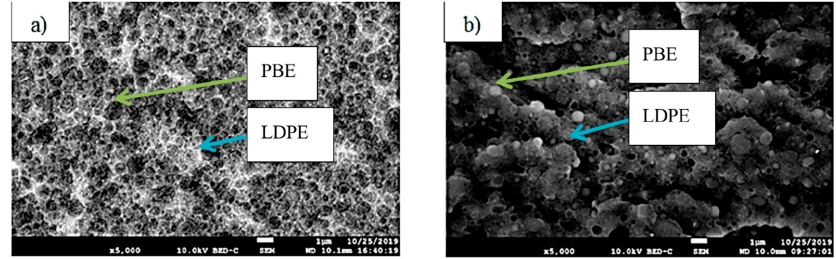
Figure 5. SEM images of the cross sections of 60%LDPE / 40%PBE ( a ) and 40%LDPE / 60%PBE ( b ). LDPE is whiter and in the PBE is darker.